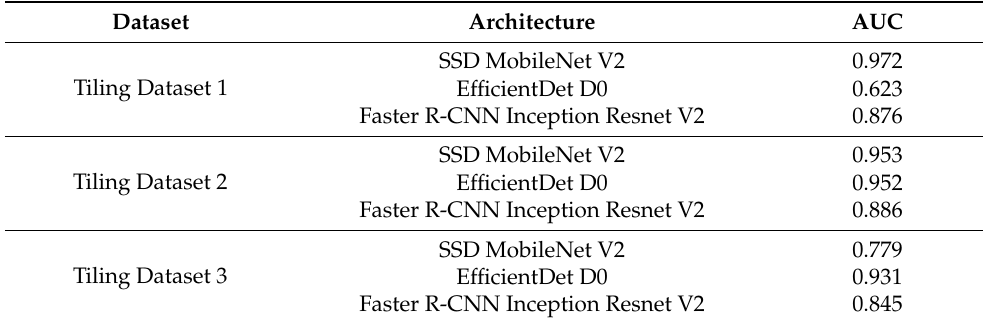
Figure 13. ROC curves of SSD MobileNet V2, EfficientDet D0, and Faster R-CNN Inception Resnet V2 from ( a ) Tiling Dataset 1, ( b ) Tiling Dataset 2 and ( c ) Tiling Dataset 3. Table 8. AUC of ROC curve on image tiling